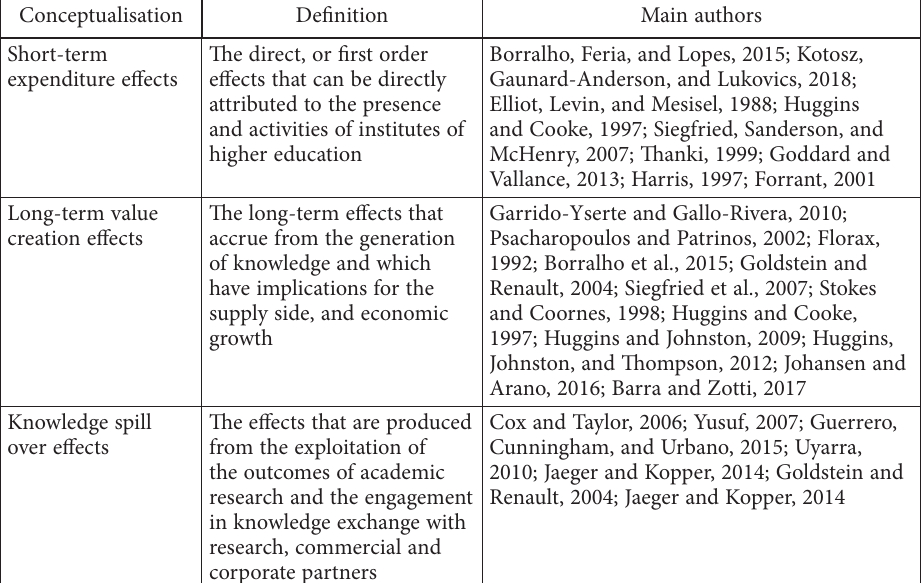
Table 1. Conceptualising economic impact (source: compiled by